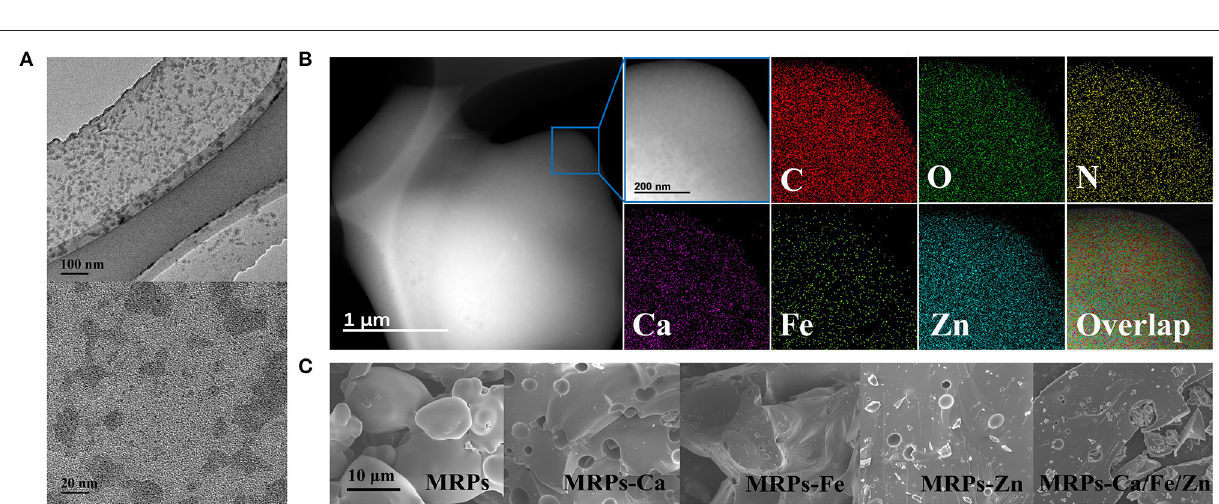
Frontiers in Nutrition |